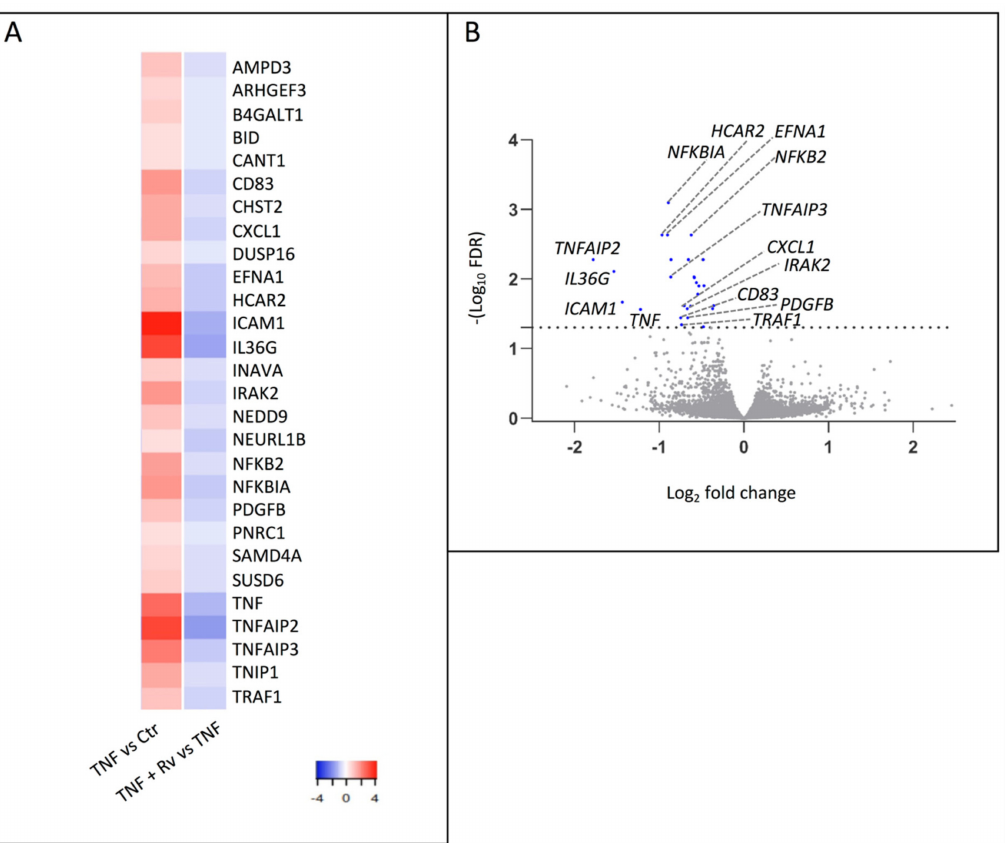
Figure 2. Differentially expressed genes in TNF- α -activated oral epithelial cells treated with RvD1 n-3 DPA . ( A ) Based on FDR, 28 genes were differentially expressed between oral epithelial cells treated with TNF- α + RvD1 n-3 DPA versus TNF- α alone (blue). All genes were down-regulated. In red, the expression of the same genes is shown when TNF- α addition is compared with control (vehicle). ( B ) Volcano plot of the differentially expressed genes when TNF- α + RvD1 n-3 DPA and TNF- α addition were